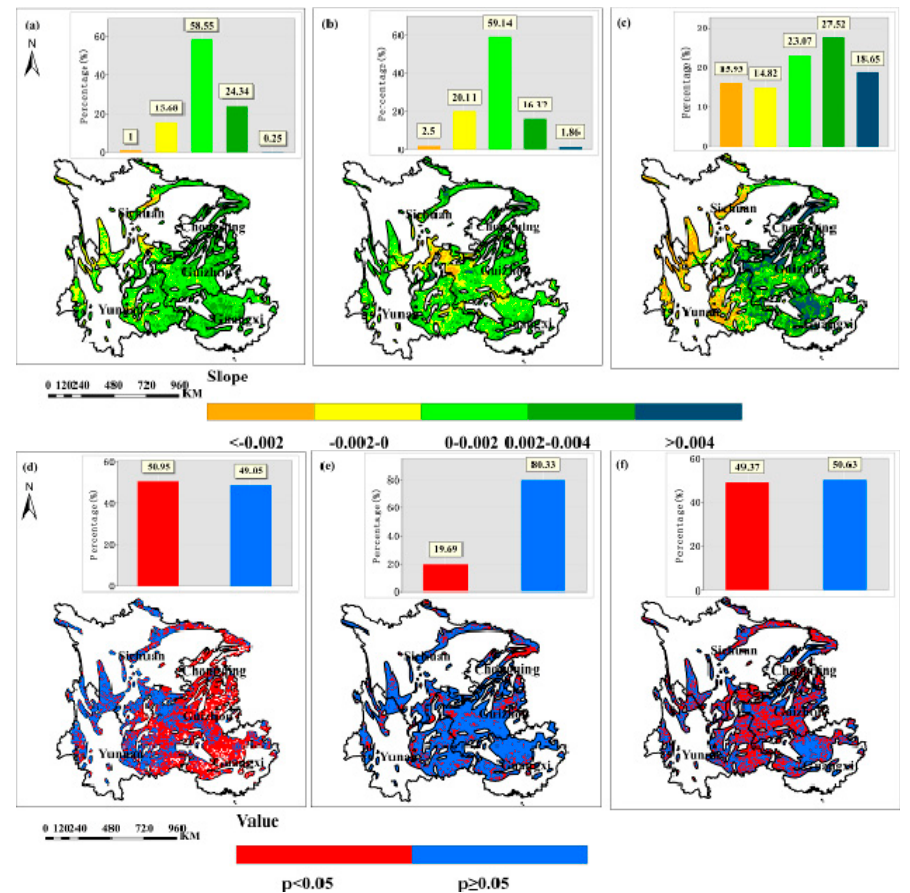
Figure 4. The linear change rate and the significance level of the trend in the growing season NDVI. ( a – c ) show the linear change rate of the NDVI trend in the entire period, before the breakpoint and after the breakpoint. ( d – f ) show the significance level of the NDVI trend during the entire period, before the breakpoint and after the breakpoint. The insets show the frequency distribution of the corresponding values.